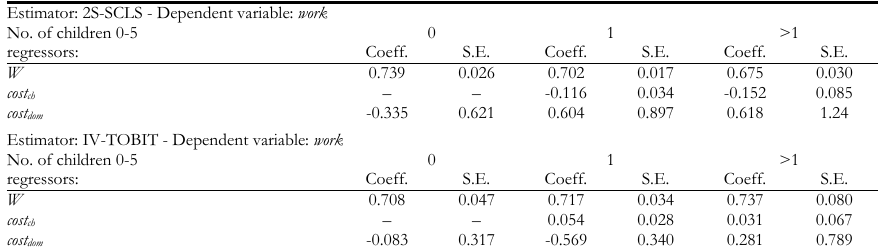
Wage-elasticity and unpaid-work elasticity estimated